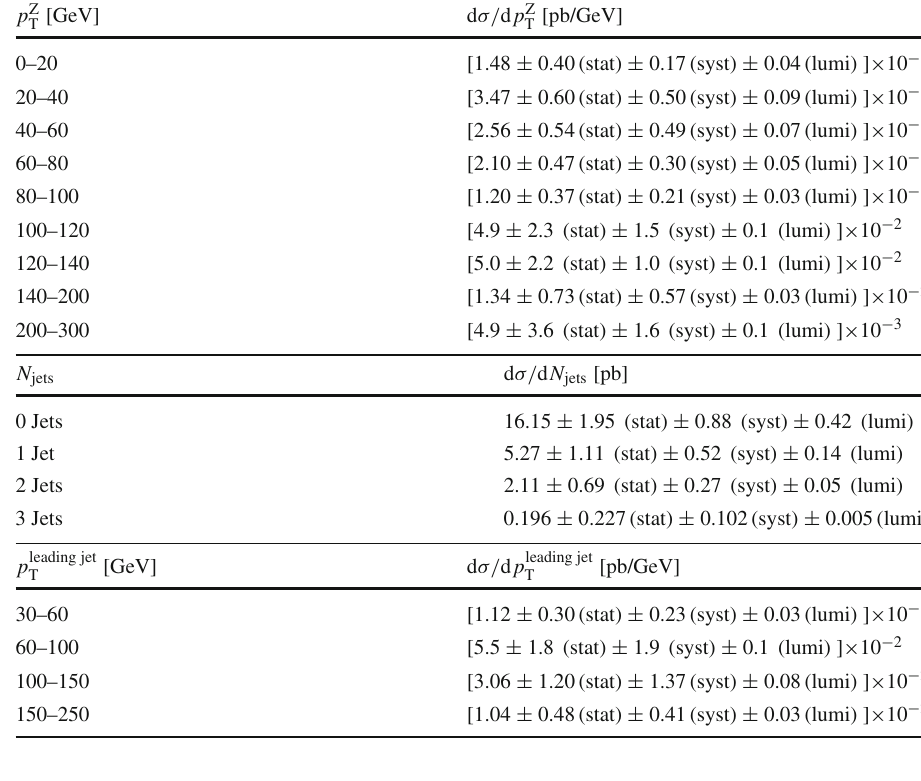
Table 7 Combined result for the differential WZ cross √ s = 8TeV sections at